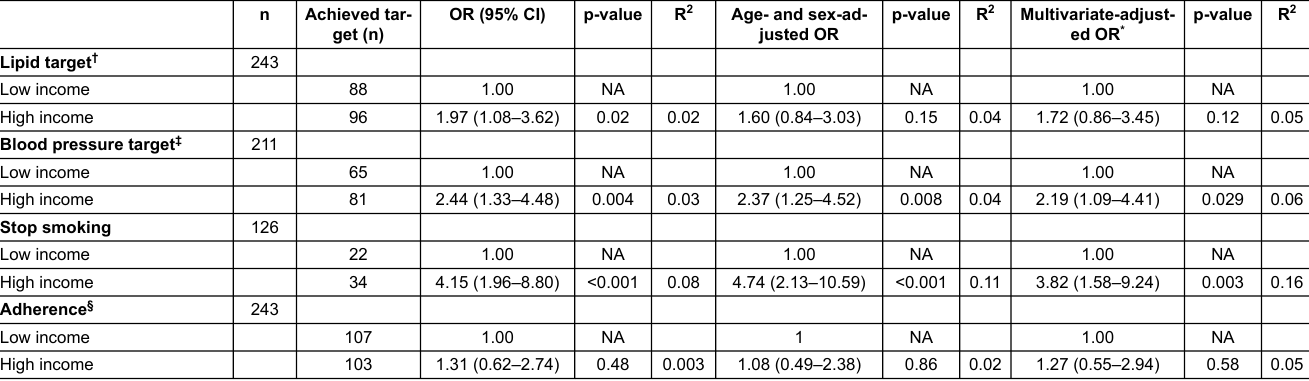
Table 2: One-year control of cardiovascular risk factors and household income